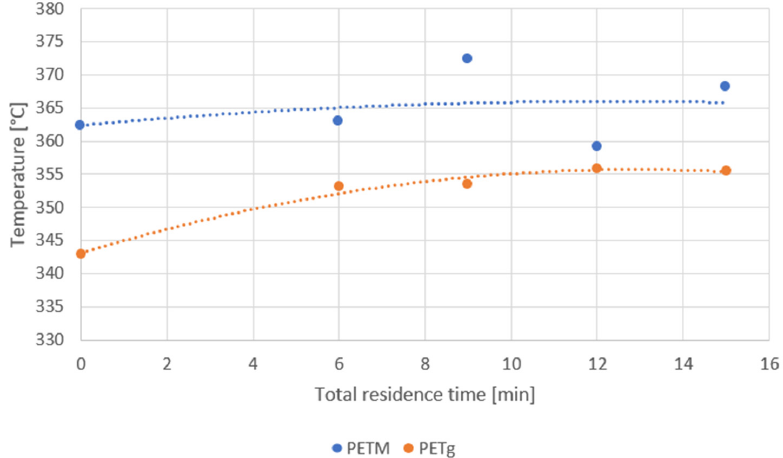
Figure 7. Temperature at which the residence time sample, extruded with the HAAKE Minilab twin-screw extruder, lost 5% of its mass, with the dashed lines as a guide for the eye. For PETg, a clear trend is visible (orange symbols, Figure 7). The longer the residence time, the higher the temperature at which the sample lost 95% of its mass. A possible ex- planation is that, due to oxidation during processing, structures were formed which were more stable than the original polyester chains, leading to slower thermal degradation of the sample. Notably, the thermal stability of the virgin pellets was significantly smaller than for the residence time samples, as the 5% mass loss temperature differed by 3%. For PETM, no clear trend can be seen (blue symbols, Figure 7). It is probable that the deviation in the measurements of the PETM samples was too large and these results